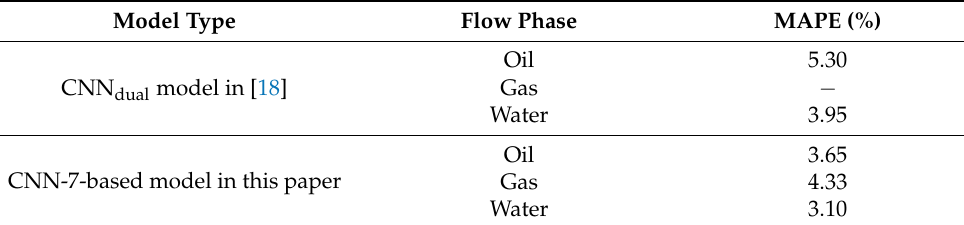
Table 6. MAPE comparison between CNN dual model in [18] and CNN-7-based model in this paper. Model Type